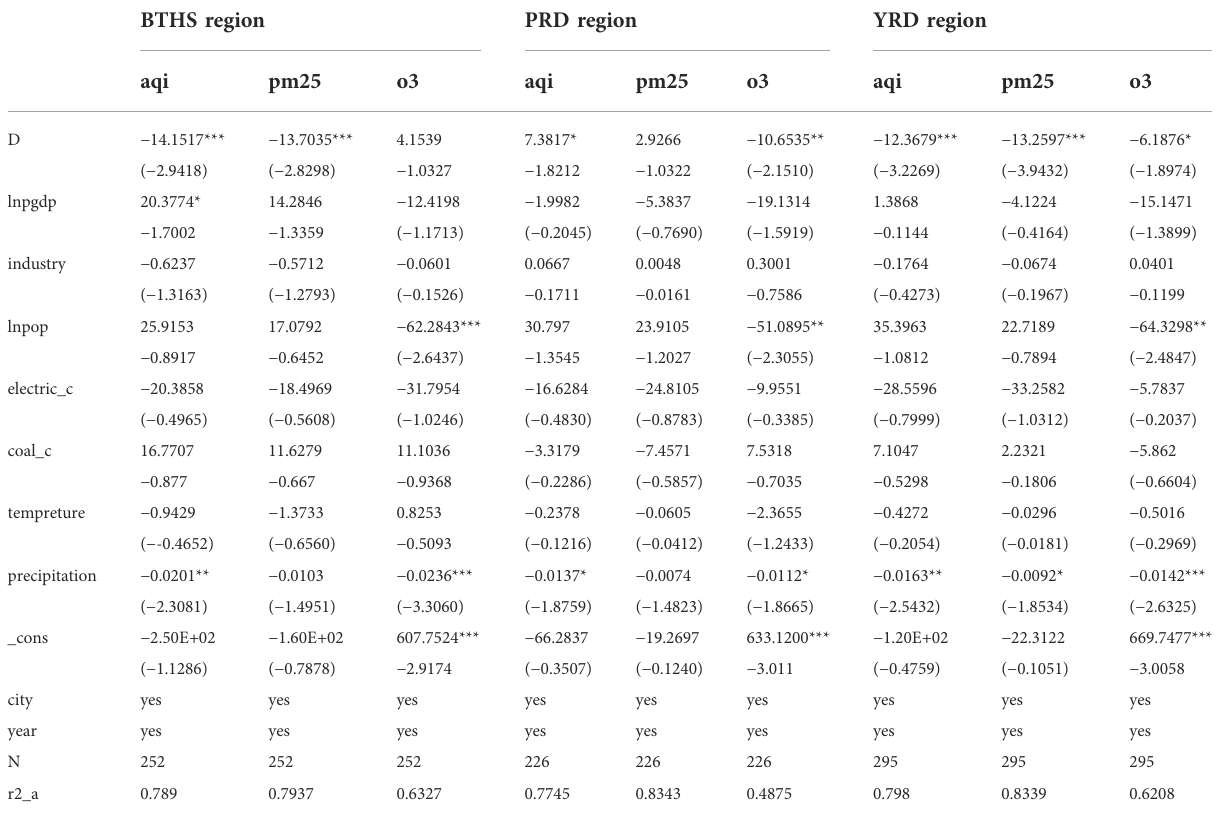
TABLE 3 Estimation results of the heterogeneity effects of